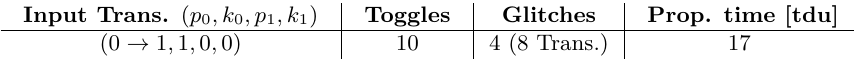
Table 3: Number of gate toggles and glitches caused by the exemplary input transition and the total propagation time.